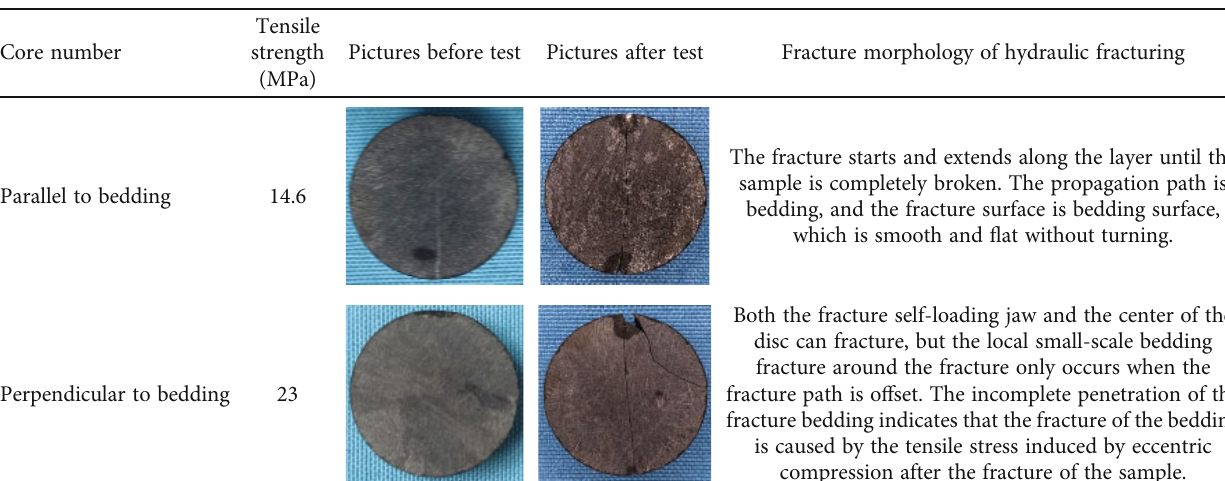
Table 2: Diagram of experimental fractures in Brazilian